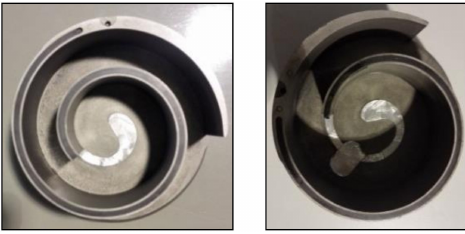
Figure 7. Cutting photos of intake